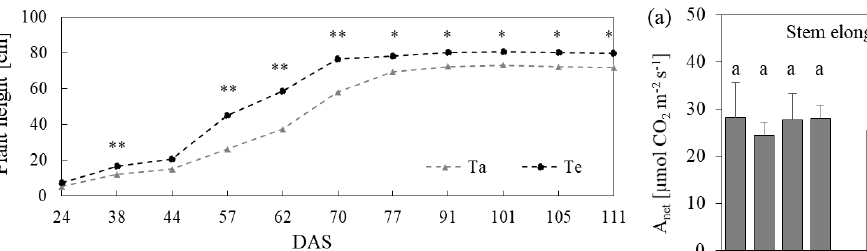
Fig. 2: Plant height measured between 24 DAS and 111 DAS at ambient (T a ) and elevated soil temperature (T e ). Asterisks indicate significant differences between plants under ambient and elevated soil tempera- tures (*P ≤ 0.05; **P ≤ 0.01); n = 4.